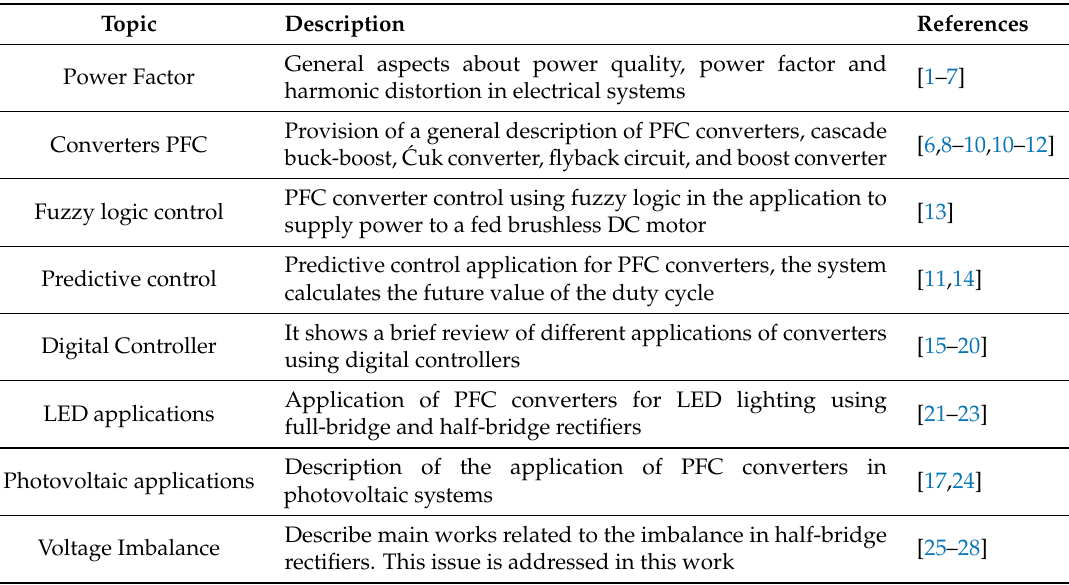
Table 1. Description of the related